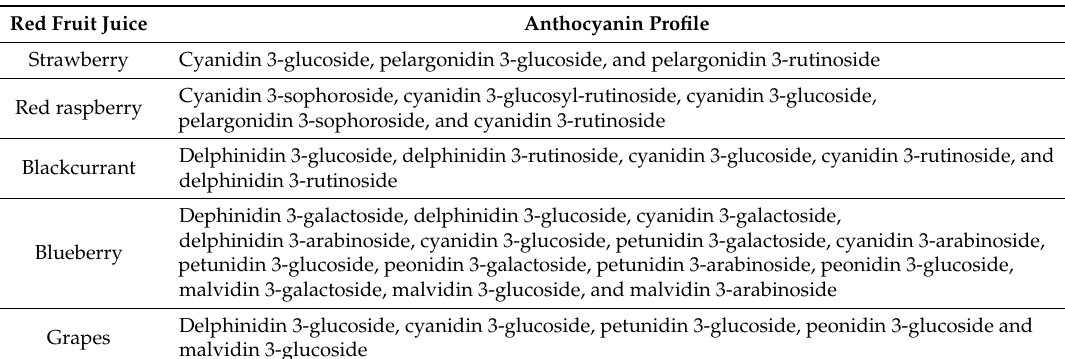
Table 1. Anthocyanin profile from different red fruit juices. Adapted from [20,29–37]. Red Fruit